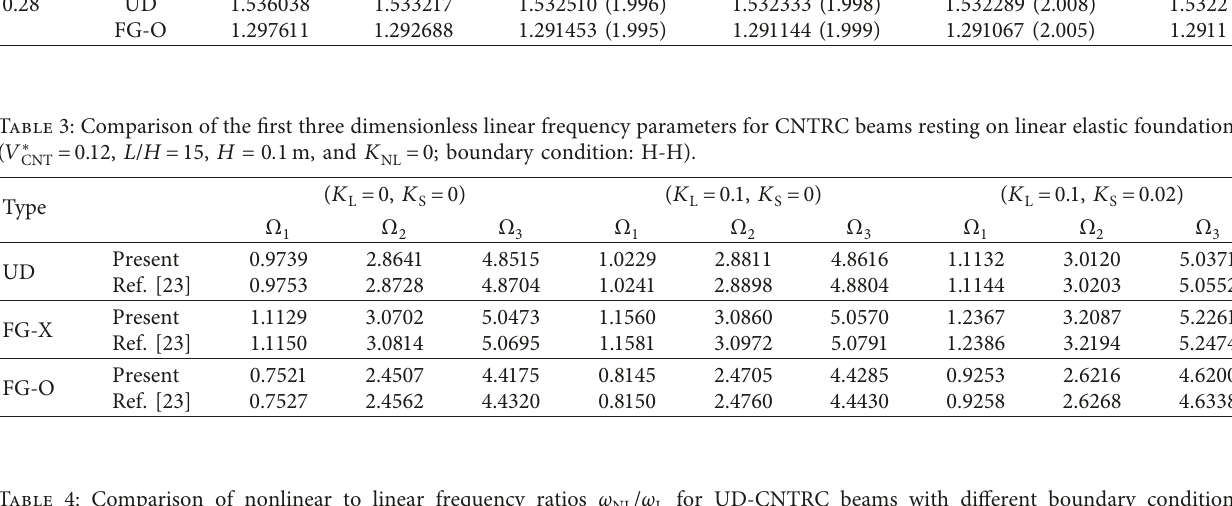
/ ω for UD-CNTRC beams with different boundary NL L